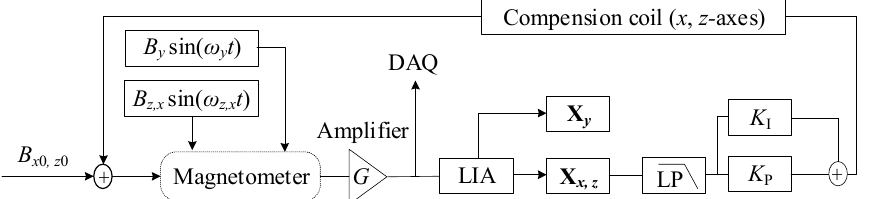
Figure 7. Flow diagram of the background magnetic field compensation for x -and z -axes, respectively. X x , y , z is the in-phase components of the demodulated amplitude.